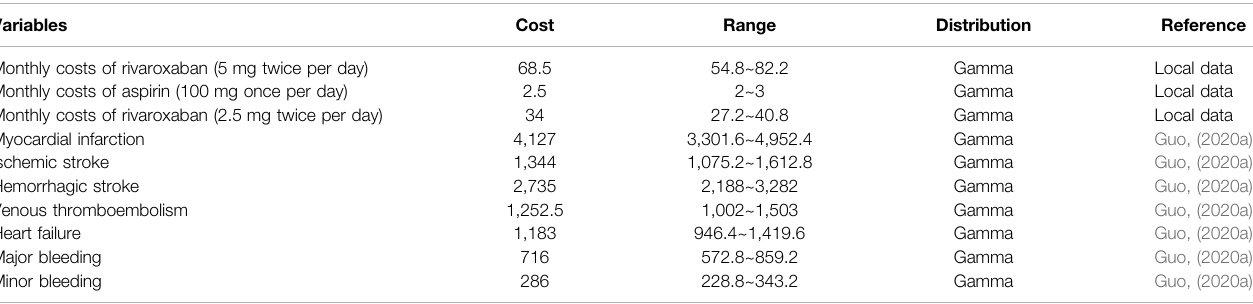
TABLE 2 | Input parameters for the costs in the model.